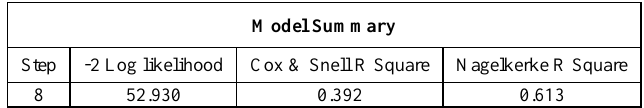
Table 2. Goodness-of-fit criterions